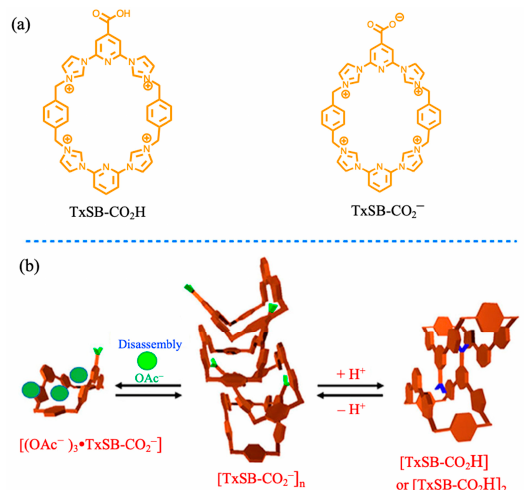
Figure 8. ( a ) Chemical structures of TxSB-CO 2 H and its corresponding base TxSB-COO − . ( b ) Sche- matic view of self-assembly of a supramolecular polymer constructed from mono